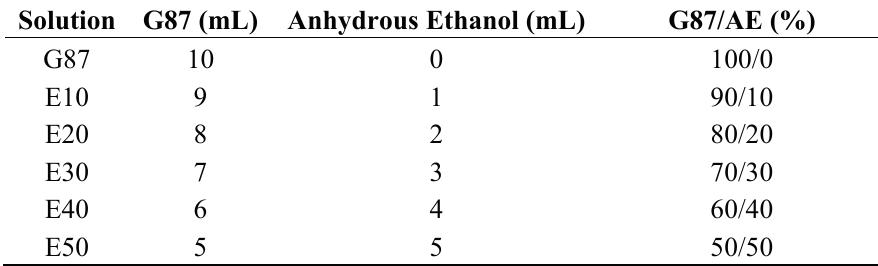
Table 1. Gasohol blends prepared using anhydrous ethanol and G87 gasoline. The blends are labeled following standard convention.